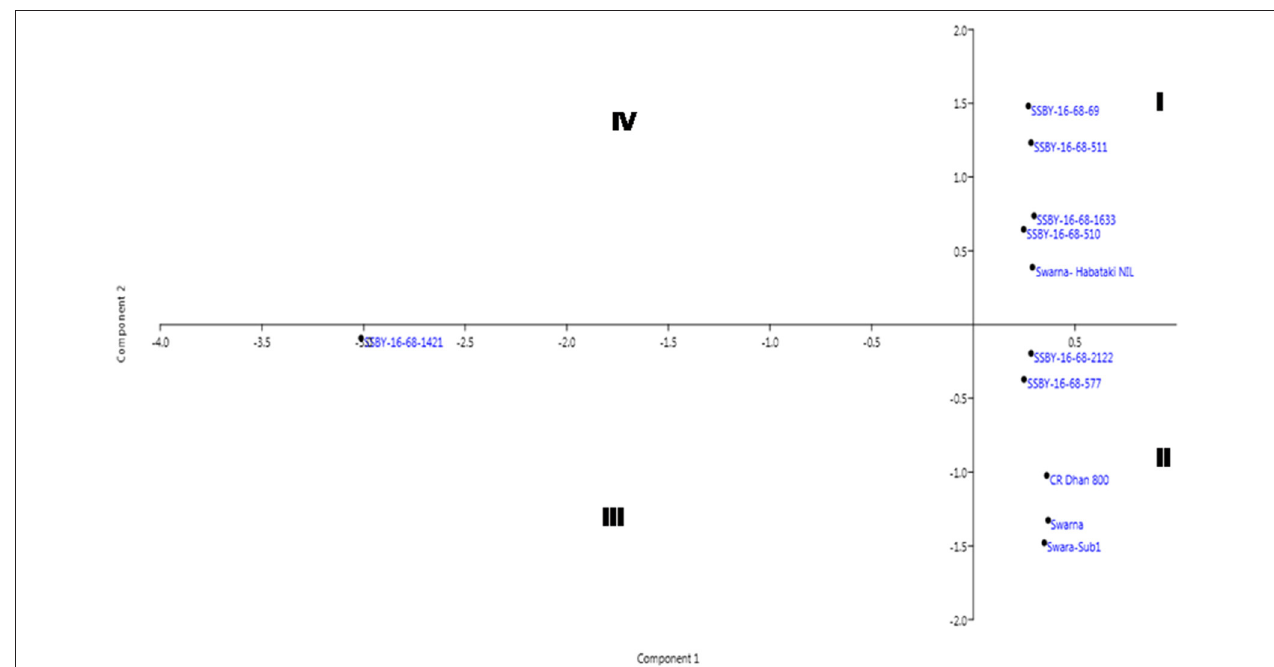
FIGURE 11 | Biplot diagram generated for the traits using the pyramided and parental lines for different traits, viz., SPW, single panicle weight (g); NPPB, number of primary panicle branches/panicle; NSBP, number of secondary branches/panicle; NGP, number of grains/panicle; SW, 1,000-seed weight (g); PL, panicle length (cm); GL, grain length (cm); GB, grain breadth (cm); HRR, head rice recovery, KEAC, kernel elongation after cooking (mm) and PY, plot yield (q/ha) of different Swarna pyramided lines and parental lines.